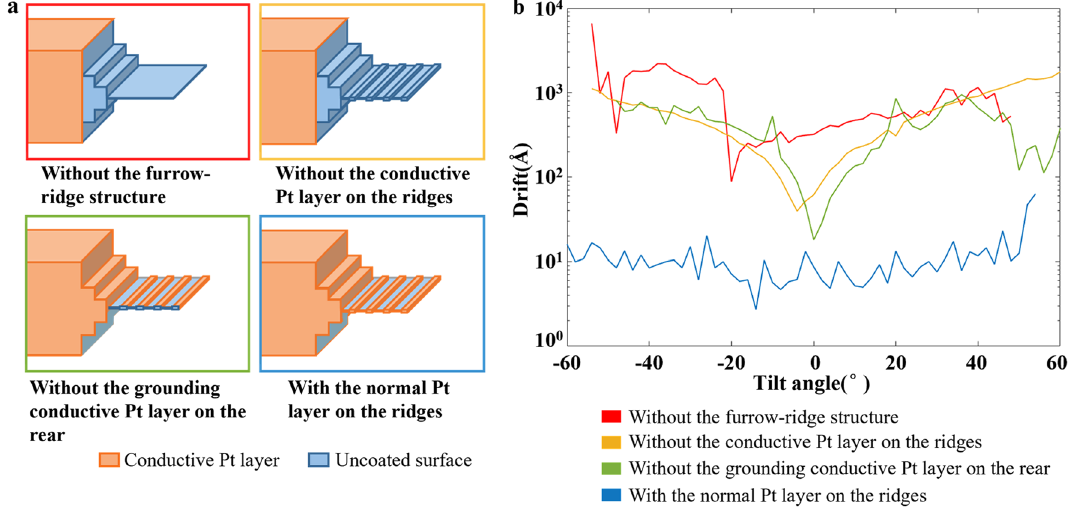
Figure 5. Beam-induced motion near the disconnected end of the lamellae with or without charge-reducing design. ( a ) Schematic diagrams of the four lamellae with different coverage of conductive Pt layers. ( b ) Representative curves (see full data in Supplementary Figs. 8 and 9) of the measured drift (motion) against the tilt angle of cryoET data collection of the four lamellae in ( a ). Different colors of curves and figure boxes indicate different lamella. The red curve is measured at position #1 in Supplementary Fig. 8a, which is 6 μm from the disconnected end. The yellow, green and blue curves are measured at position #1 in Supplementary Fig. 9a,f,k, respectively, which are all in the furrows closest to the disconnected end (~ 3.5 μm from the disconnected